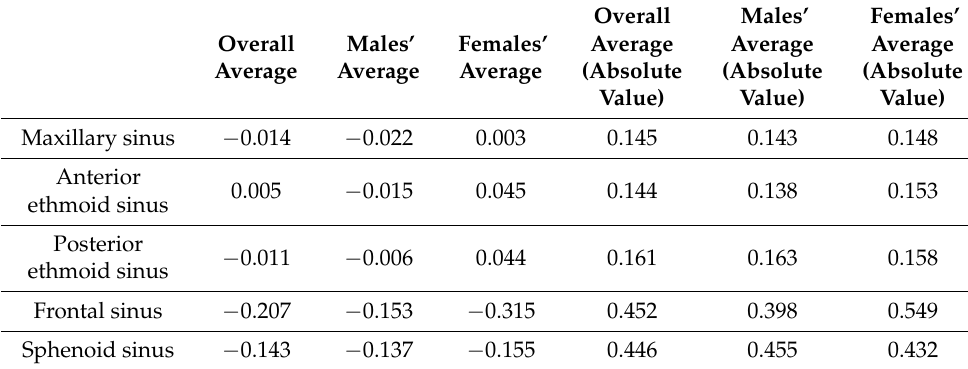
Table 8. Nasal sinus symmetry comparison